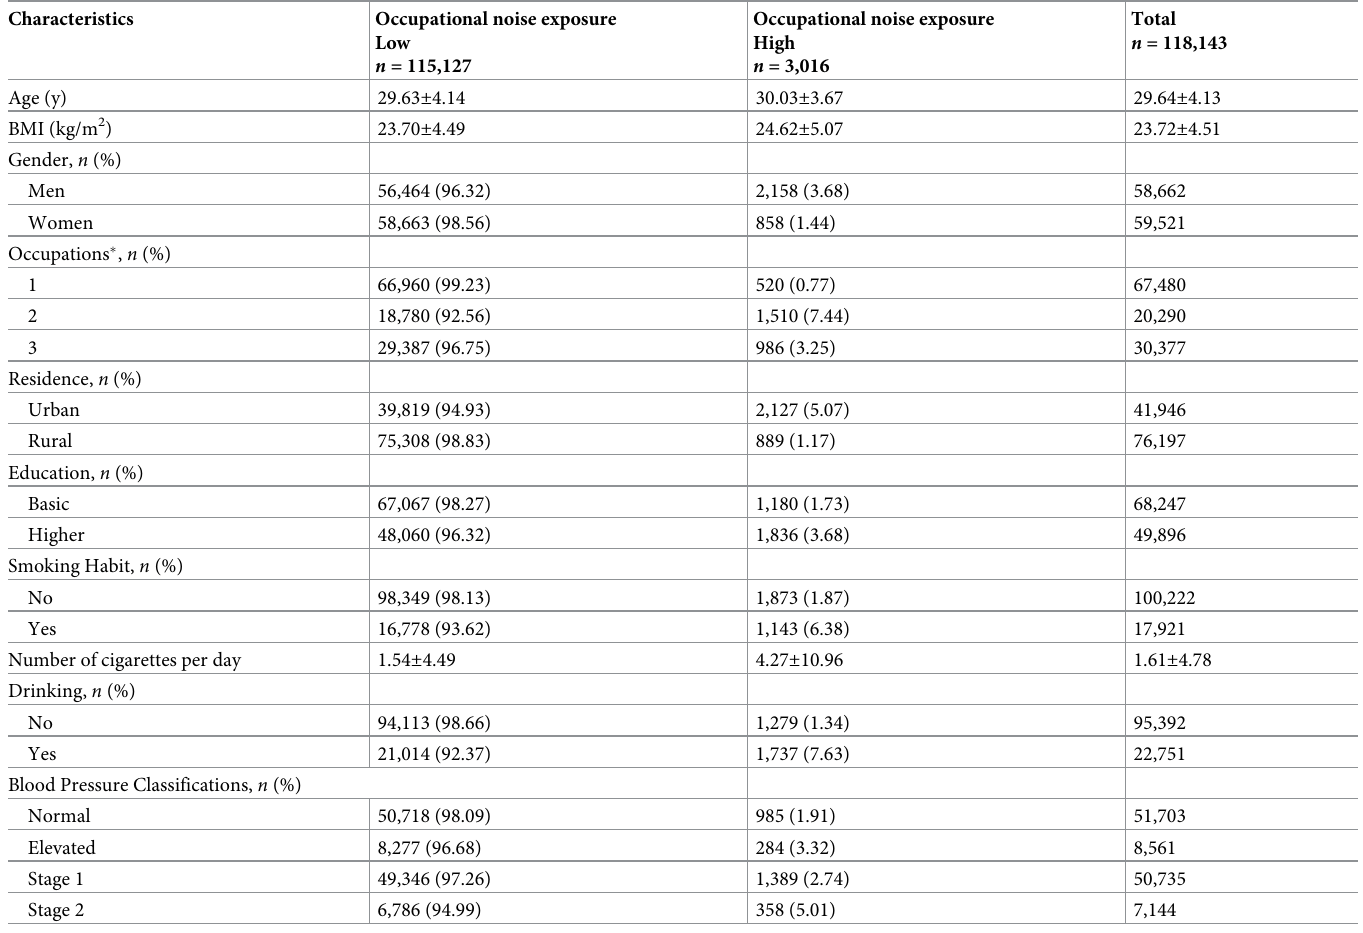
Table 1. Baseline characteristics of the